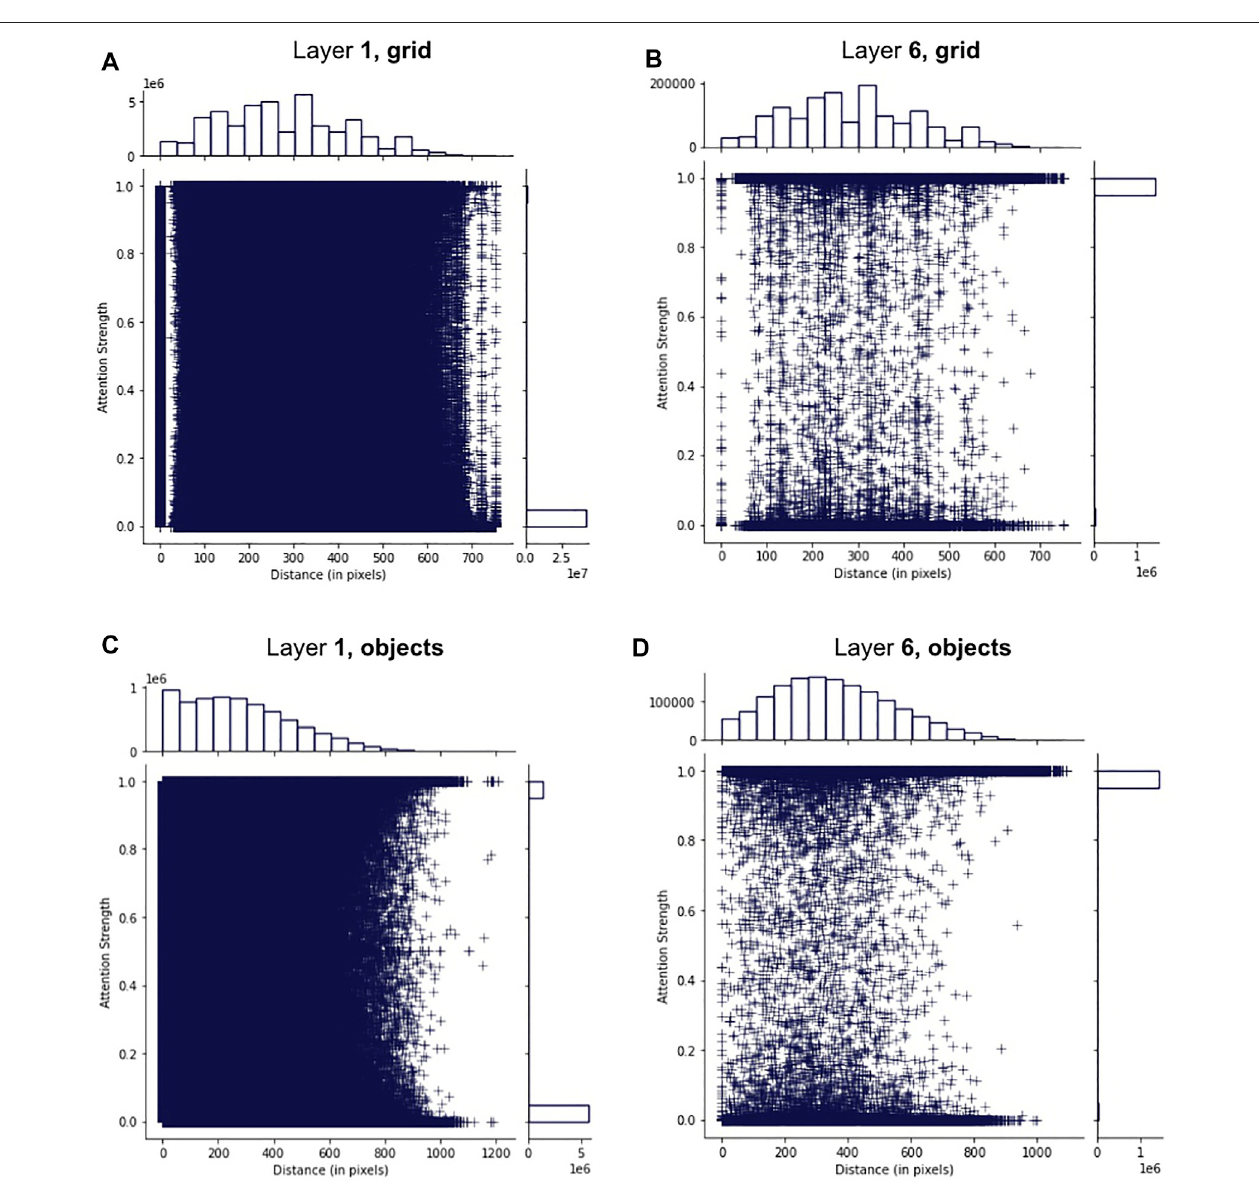
FIGURE12| Thedistribution oftheattention links(depicted as+marks) interms oftheir strength(the vertical axis)anddistancebetweencentresoftwoconnected objects (the horizontal axis). (A) and (B) correspond to the patterns from the fi rst and the last layer of the model for grid-based features (e.g., image patches), while (C) and (D) represent links when we use object representations as input features. We disregard objects ’ thematic clusters in these visualisations for a fair comparison with the grid-based approach. Information about other parts of the fi gures (e.g. histograms) is identical to the description in Figure 6 .